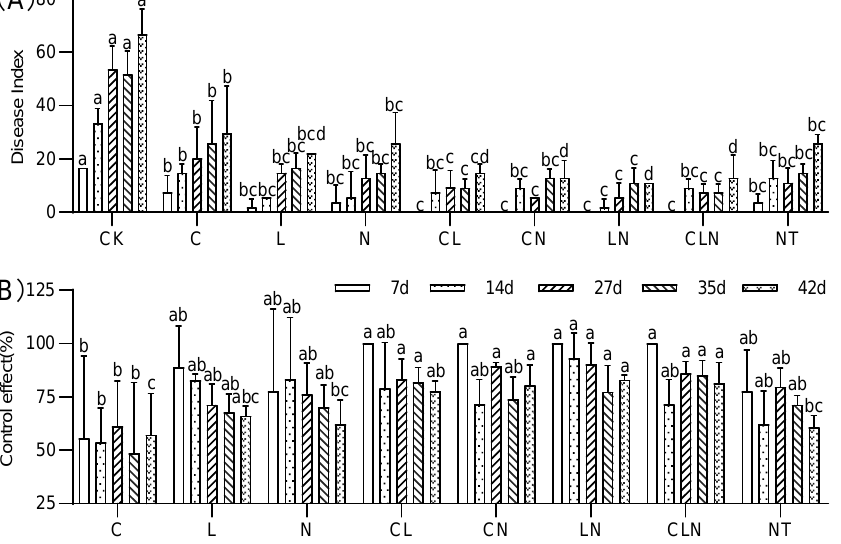
Table 3. Growth analysis of stem and leaf in seedling stage in Papaya.